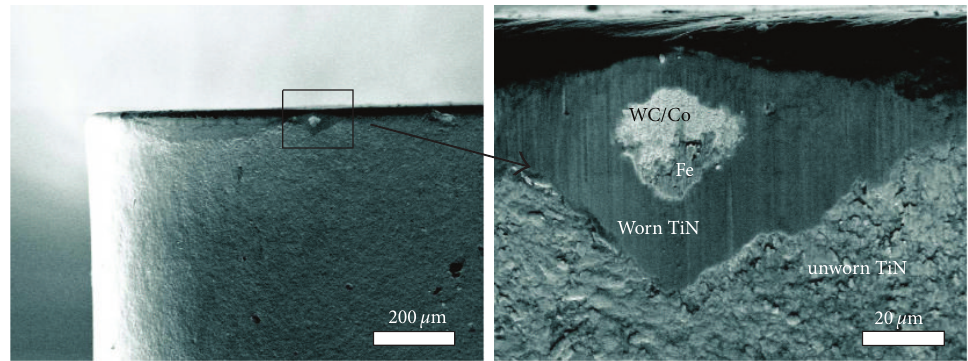
Figure 13: Small region of flank wear (resp. notch wear) of TiN-coated cutting tool, which was used under the cutting conditions of 𝑓 = 0.5 mm/rev, and 𝑎 = 0.1 𝑣 𝑐 = 100m/min, 𝑝